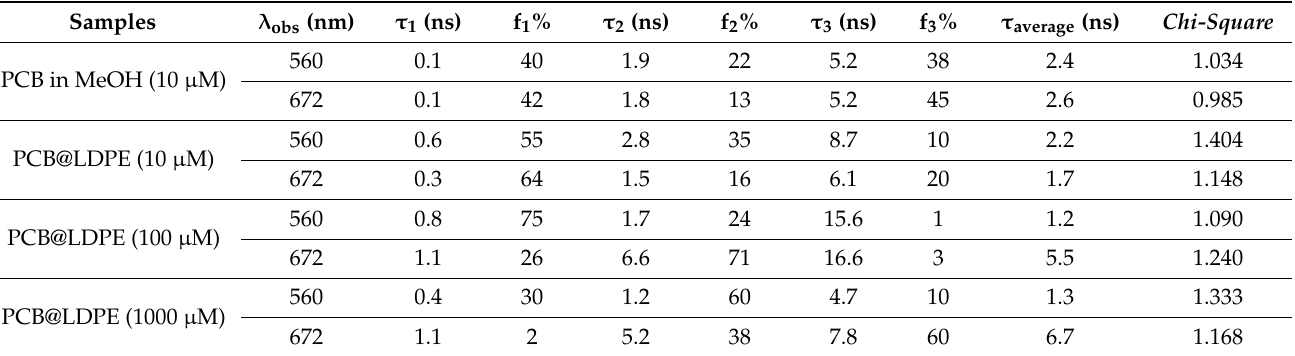
Table 2. The observed excited-state lifetime of PCB-loaded LDPE films (PCB in methanol were added for comparison).